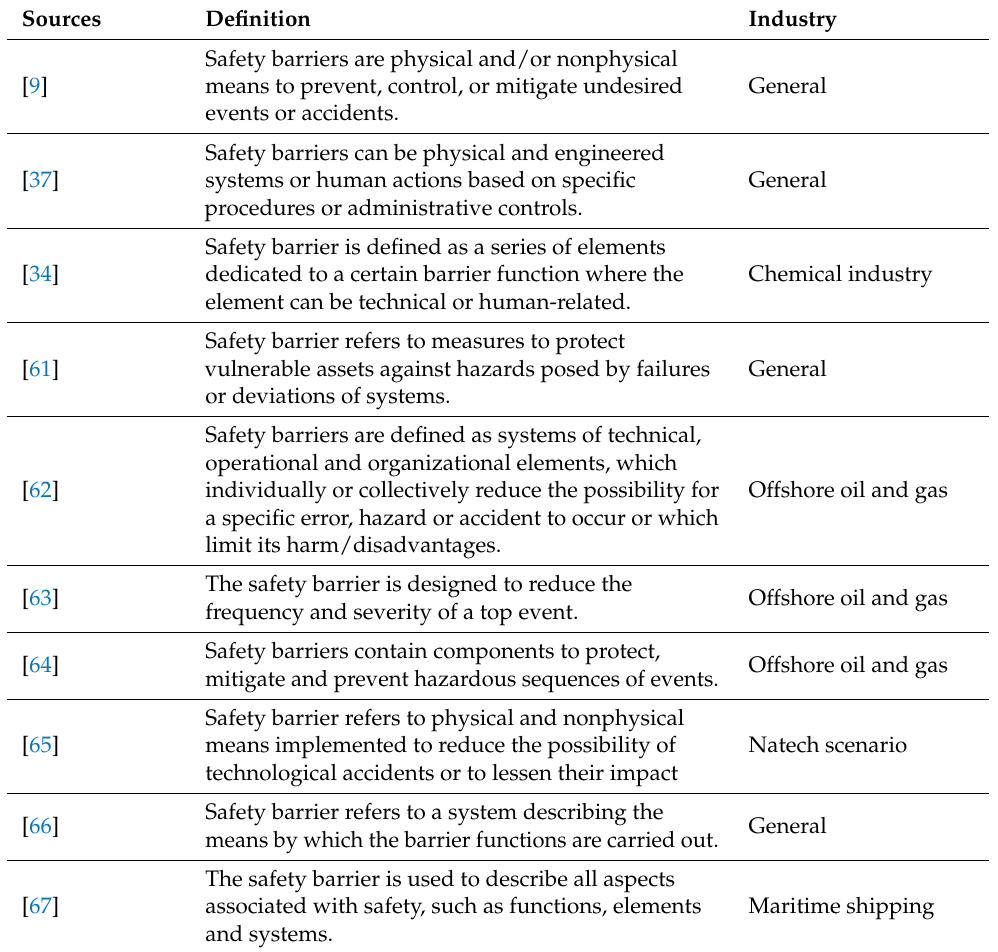
Table 3. Definitions of safety